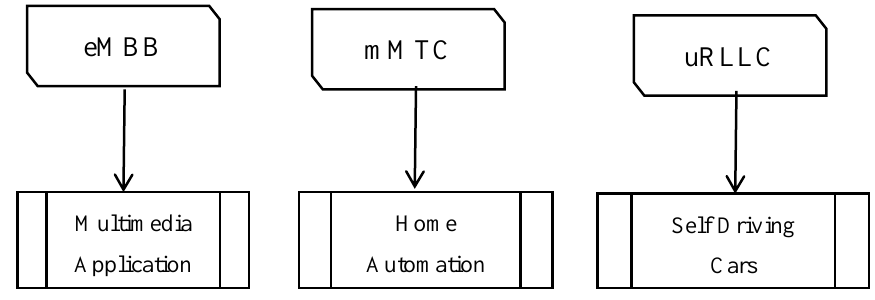
Figure 1. Use Cases.